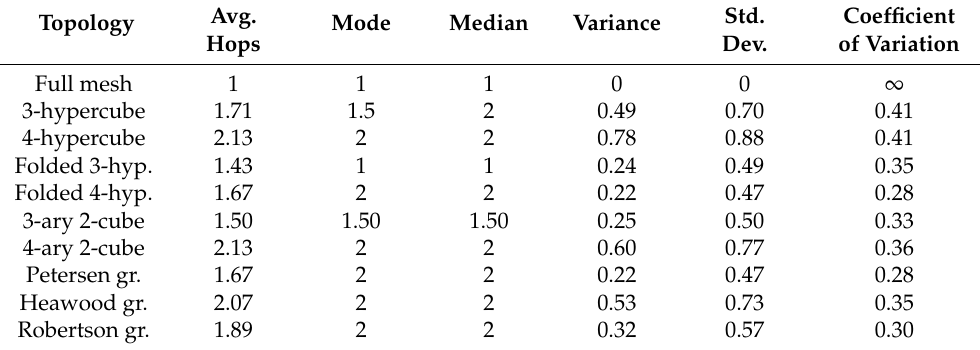
Table 8. Statistics related to the average number of hops in each network topology. Topology Avg. Mode Median Variance Std. Hops